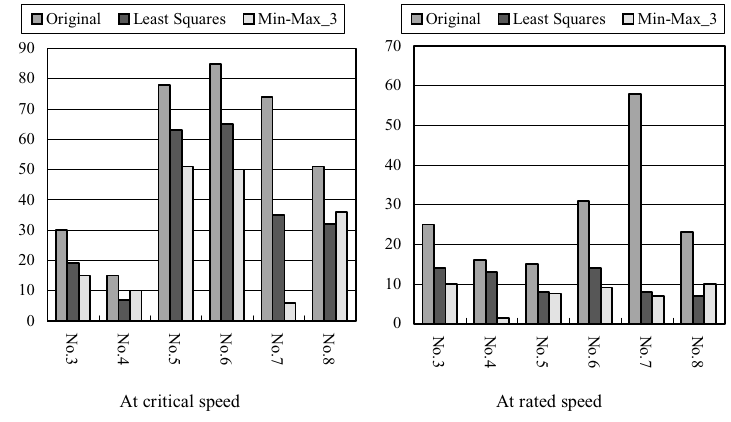
Fig. 7. Amplitude comparison: Original, least squares and min-max 3 balancing